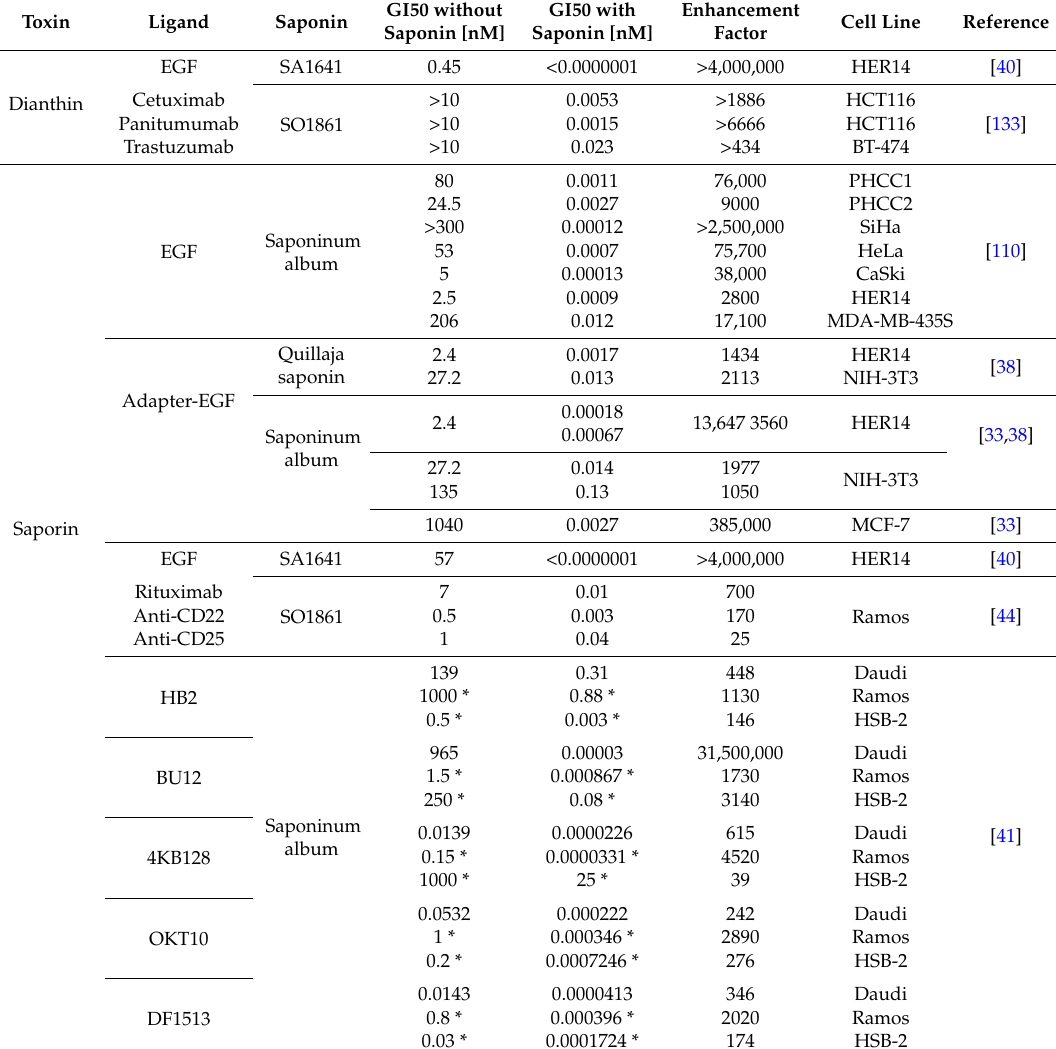
* Estimated number obtained from Figure 5 of the corresponding reference. EGF: epidermal growth factor; HER14: embryonic mouse fibroblasts (NIH-3T3) stably transfected with human epidermal growth factor receptor; HCT116: human colorectal carcinoma cells; BT-474: human breast ductal carcinoma cells; PHCC: human cervical carcinoma cells; SiHa: human cervical squamous carcinoma cells; HeLa: human cervical adenocarcinoma cells; CaSki: human cervical epidermoid carcinoma cells; MDA-MB-435S: human breast carcinoma cells; NIH-3T3: embryonic mouse fibroblasts; MCF-7: human breast adenocarcinoma cells; Ramos: human Burkitt's lymphoma cells; Daudi: human Burkitt's lymphoma cells; HSB-2: human lymphoblastic leukemia